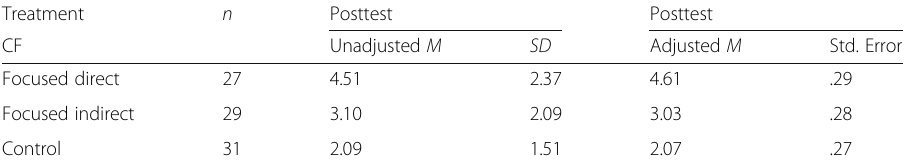
Table 9 Descriptive statistics for the untimed grammaticality judgment test Treatment n Posttest Posttest CF Unadjusted M Focused direct